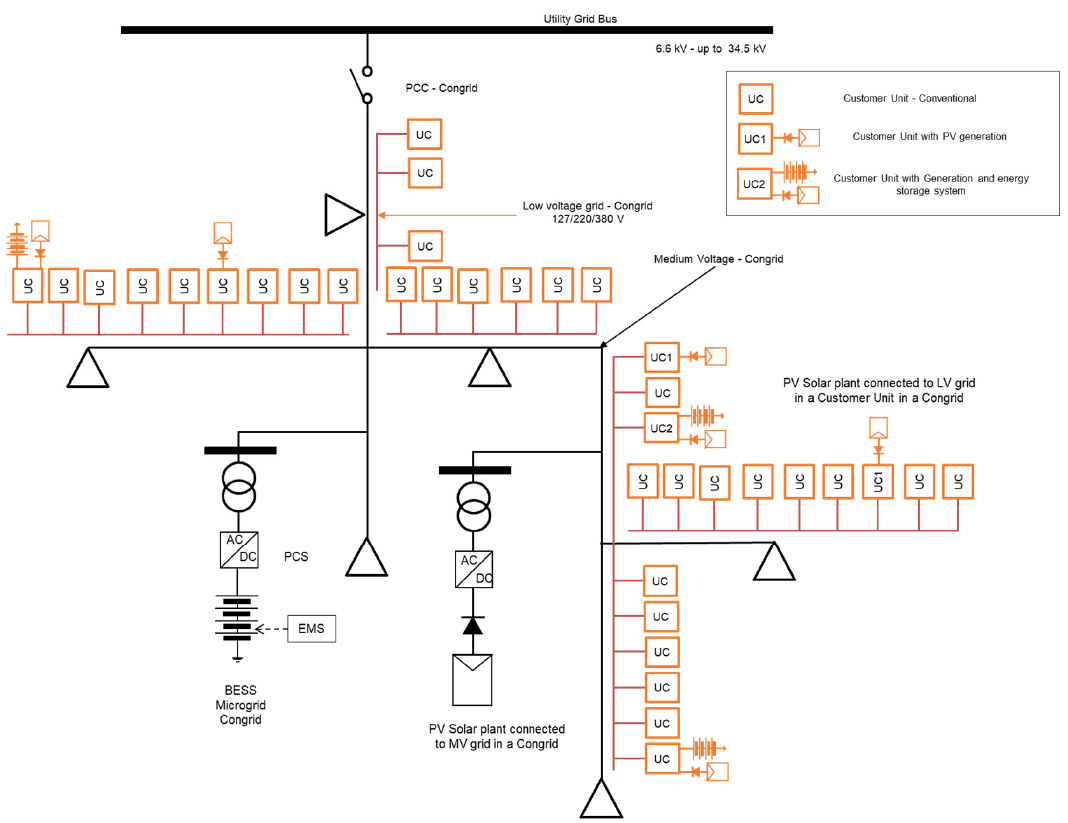
Figure 4. Congrid—a condominium microgrid.